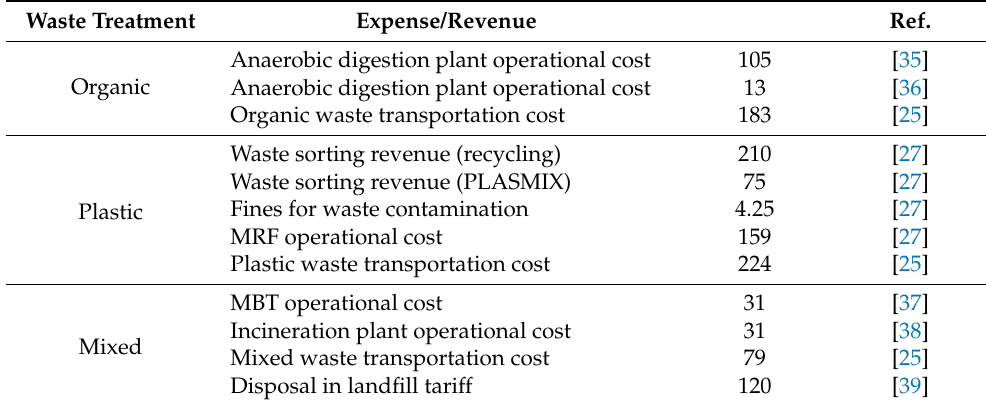
Table 1. Specific expenses and revenues in terms of EUR/ton used in the economic analysis. Waste Treatment Expense/Revenue Ref.